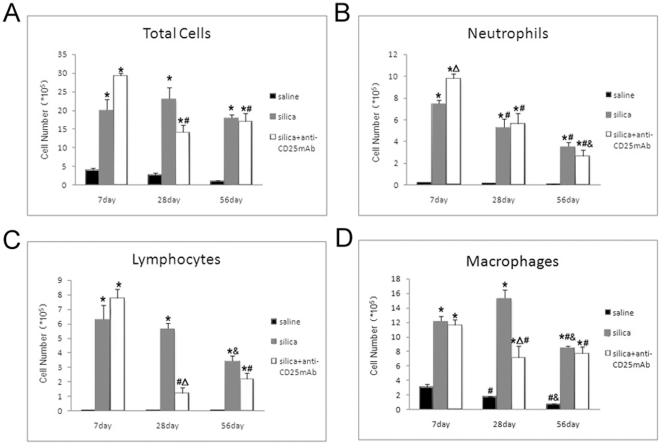
Depletion of Treg cells increases the accumulation of inflammation cells in lung response to silica.The total cells (A), neutrophils (B), macrophages (C) and lymphocytes (D) in BALF were counted by using Giemsa staining. (*, as compare with the saline control group, P<0.05; △, as compare with the silica group, P<0.05; #, as compare with 7day of the same group, P<0.05; &, as compare with 28day of the same group, P<0.05).